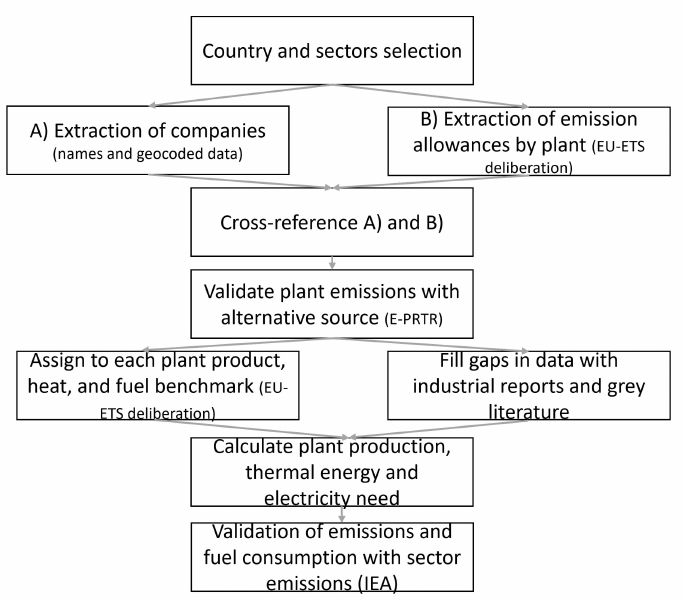
Figure 1. Visual representation of the methodology for the energy and emissions characterization of the industrial plants included in the